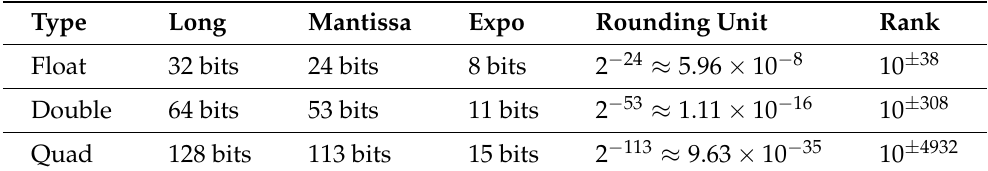
Table A1. Storage of variables in the IEEE standard in binary machines. Rounding units and range of variables according to the declared